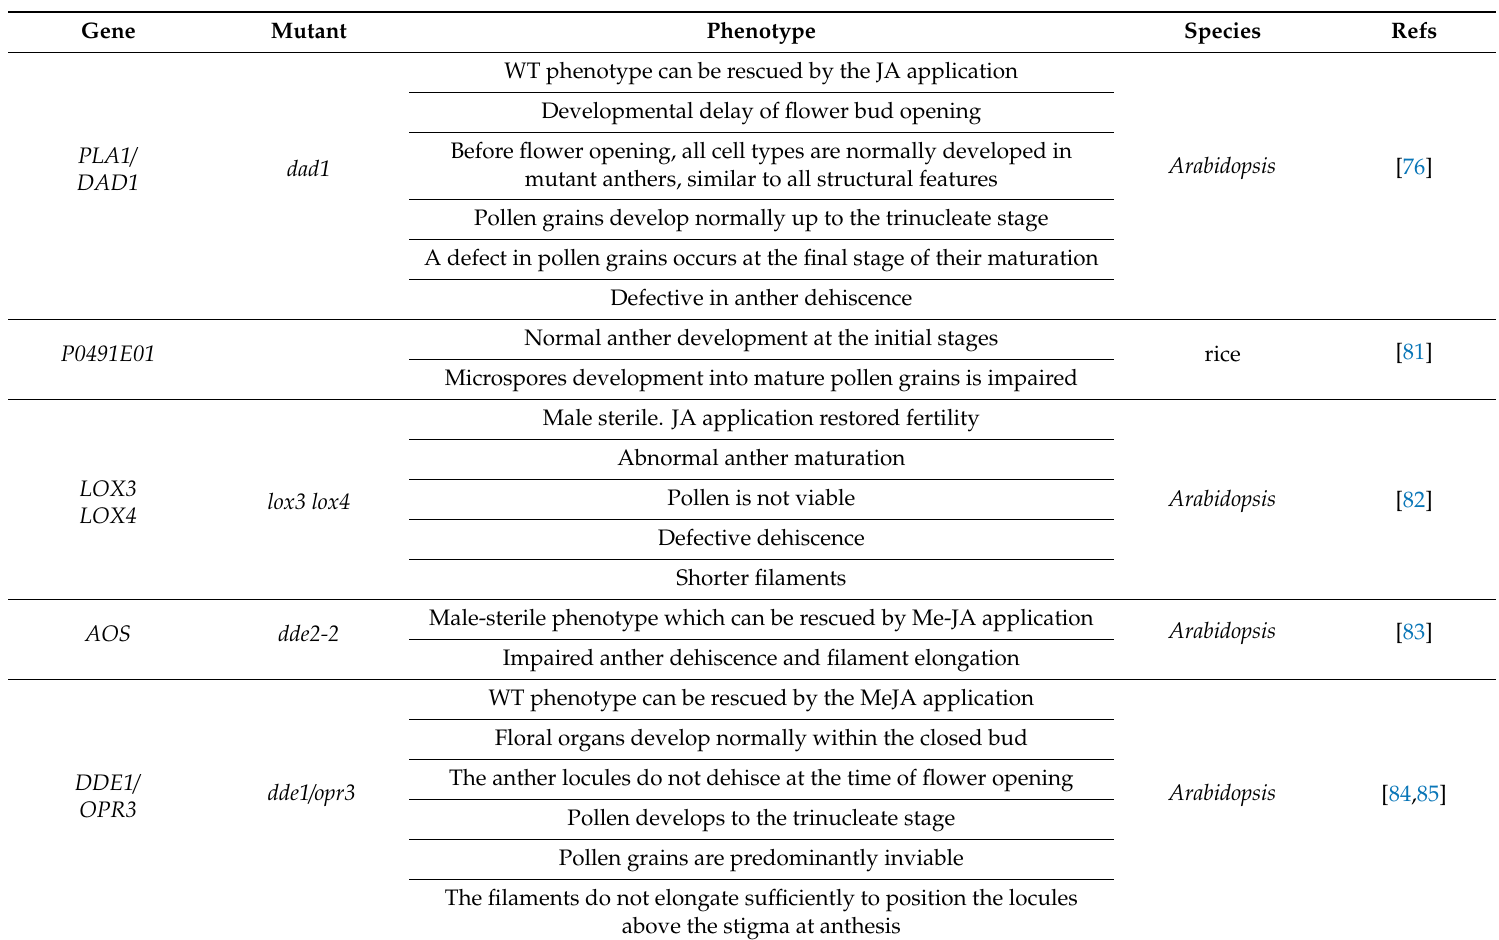
Table 3. Stamen-related features of JA-deficient mutants. Phospholipase A1 (PLA1); DEFECTIVE IN ANTHER DEHISCENCE1 (DAD1); 13-lipoxygenase